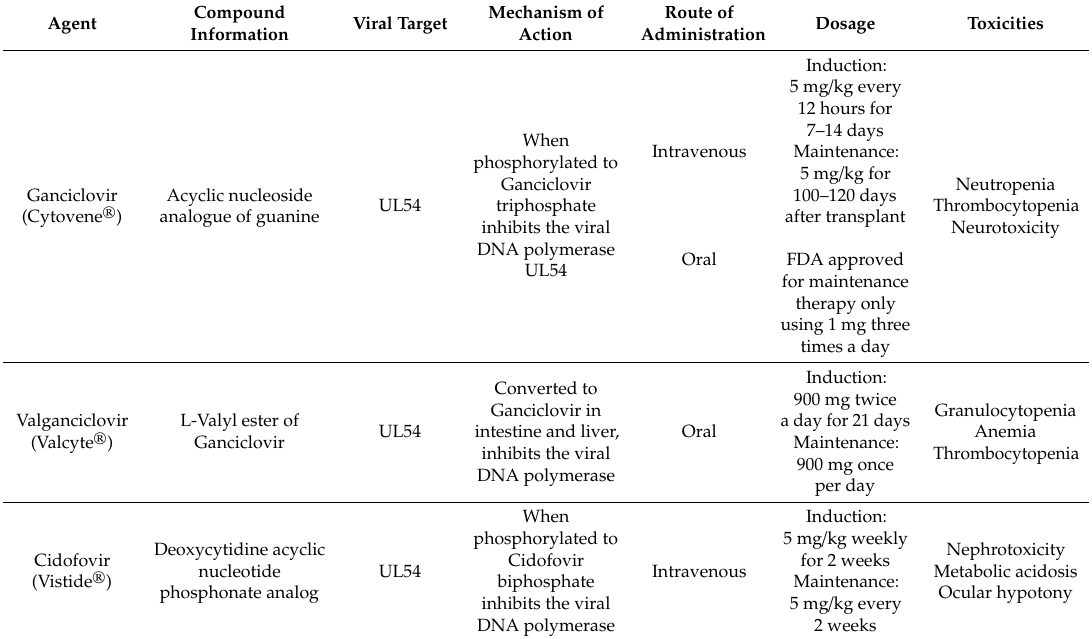
Table 3. Antiviral agents approved for treatment or prevention of HCMV